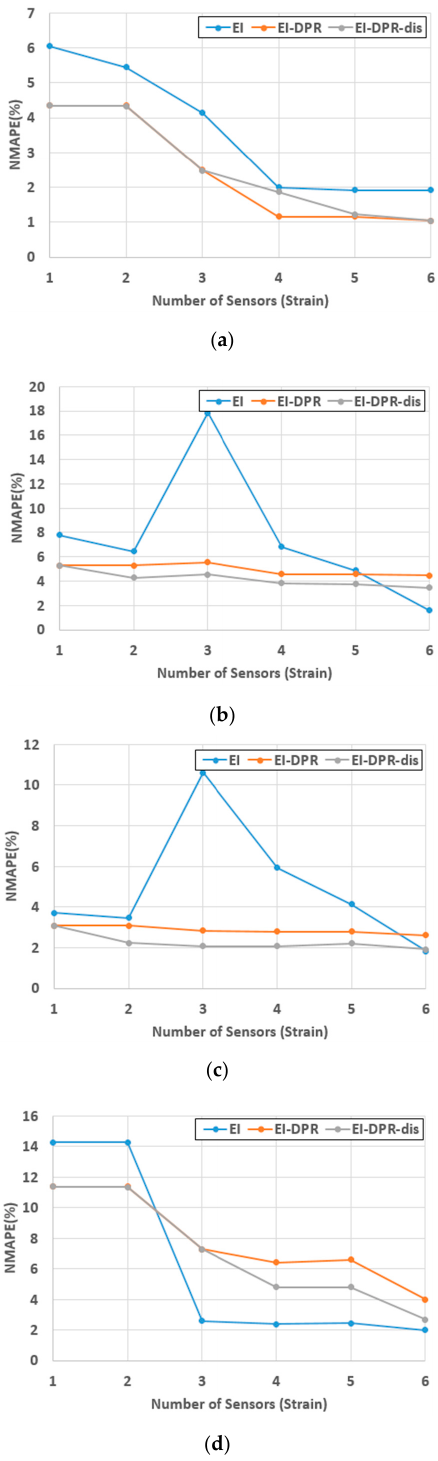
Figure 17. NMAPE by each sensor placement method according to the number of sensors (Case 2: strain with one displacement): ( a ) RDS1, ( b ) RDS2, ( c ) RDS3, ( d ) RDS4.